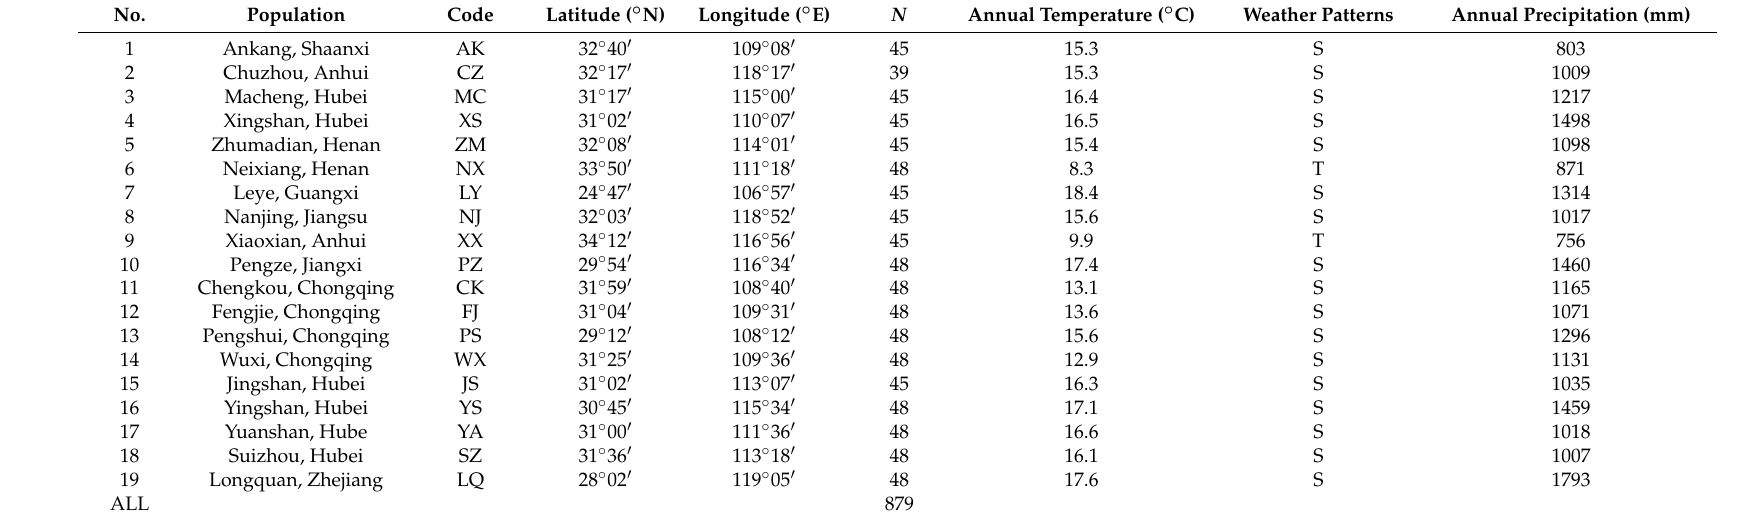
Table 1. Geographic locations and mean values of climate parameter in 19 populations of Q. variabilis